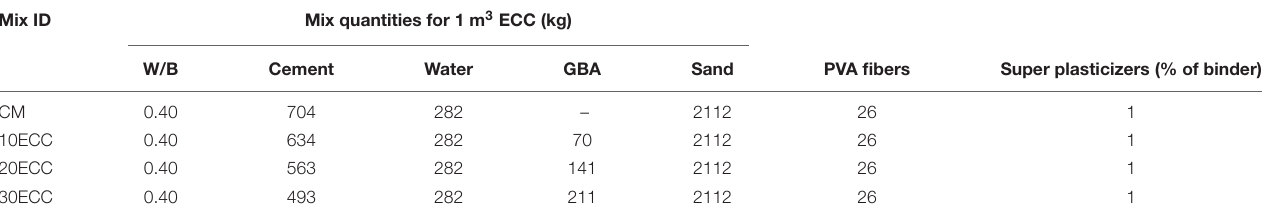
FIGURE 2 | Bagasse ash: (A) after heat treatment at 700 ◦ C for 90 min, (B) passed the 300- µ m sieve after heat treatment, and (C) ground in a ball mill for 60 min after sieving. TABLE 3 | ECC mix proportions for the control and mixes containing different percentages of GBA.